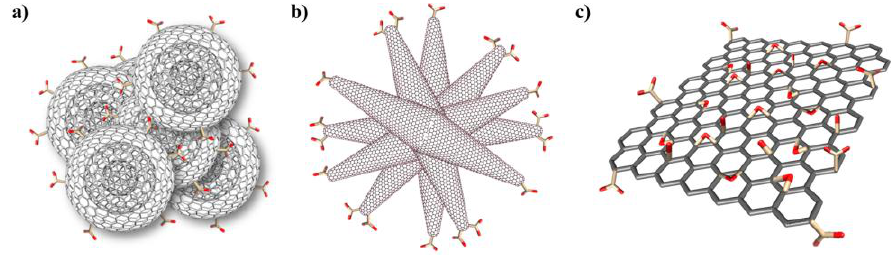
Figure 1. 3D representation of oxidized carbon nanomaterials (CNMs): ( a ) Oxidized carbon nano-onions (oxi-CNOs); ( b ) oxidized carbon nano-horns (oxi-CNHs) and ( c ) graphene oxide (GO).